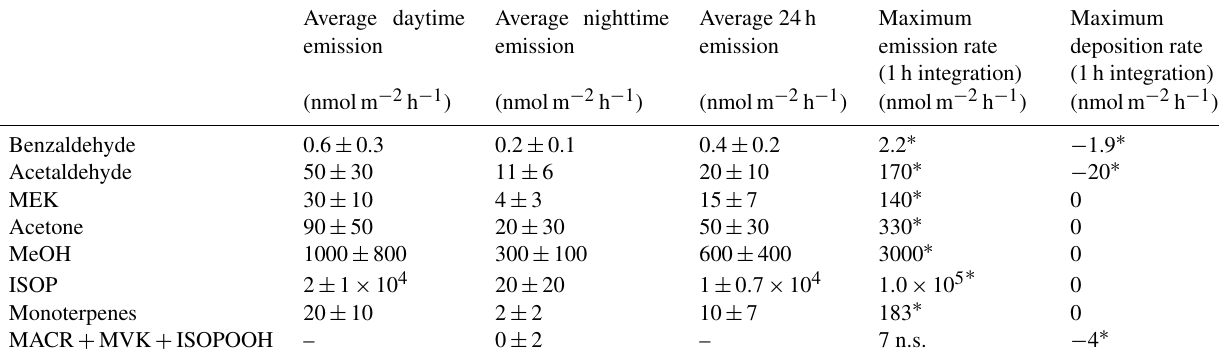
Table 1. Average measured emission and deposition rates at branch scale in the upper canopy (14–25 August). Data are reported as mean ± standard deviation. Maximum emission and deposition rates are also reported as well as an indication of their statistical significance ( ∗ indicates p< 0 . 05; n.s. indicates not significant).